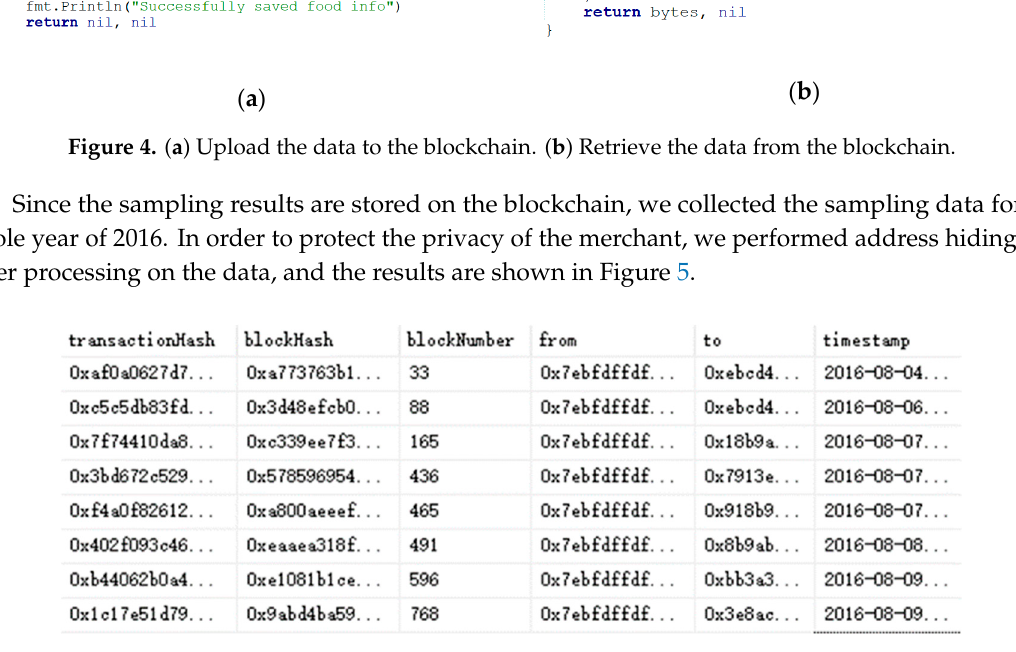
Figure 5. Data in the blockchain.